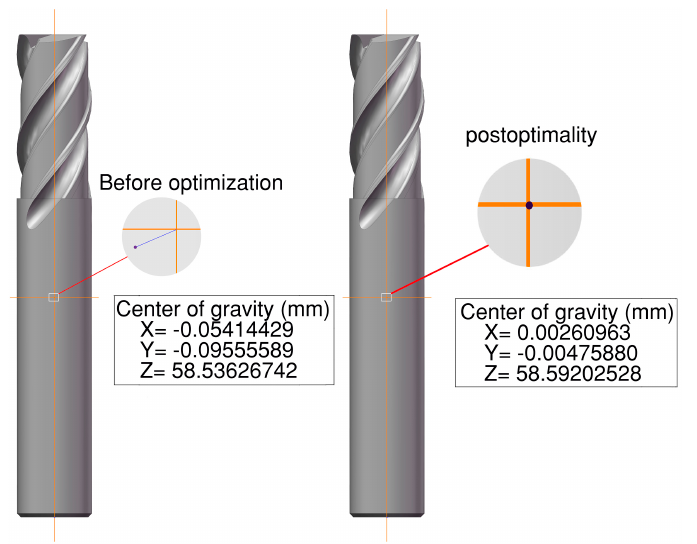
Figure 1. Optimization of helical flute of irregular tooth end milling cutter [15].